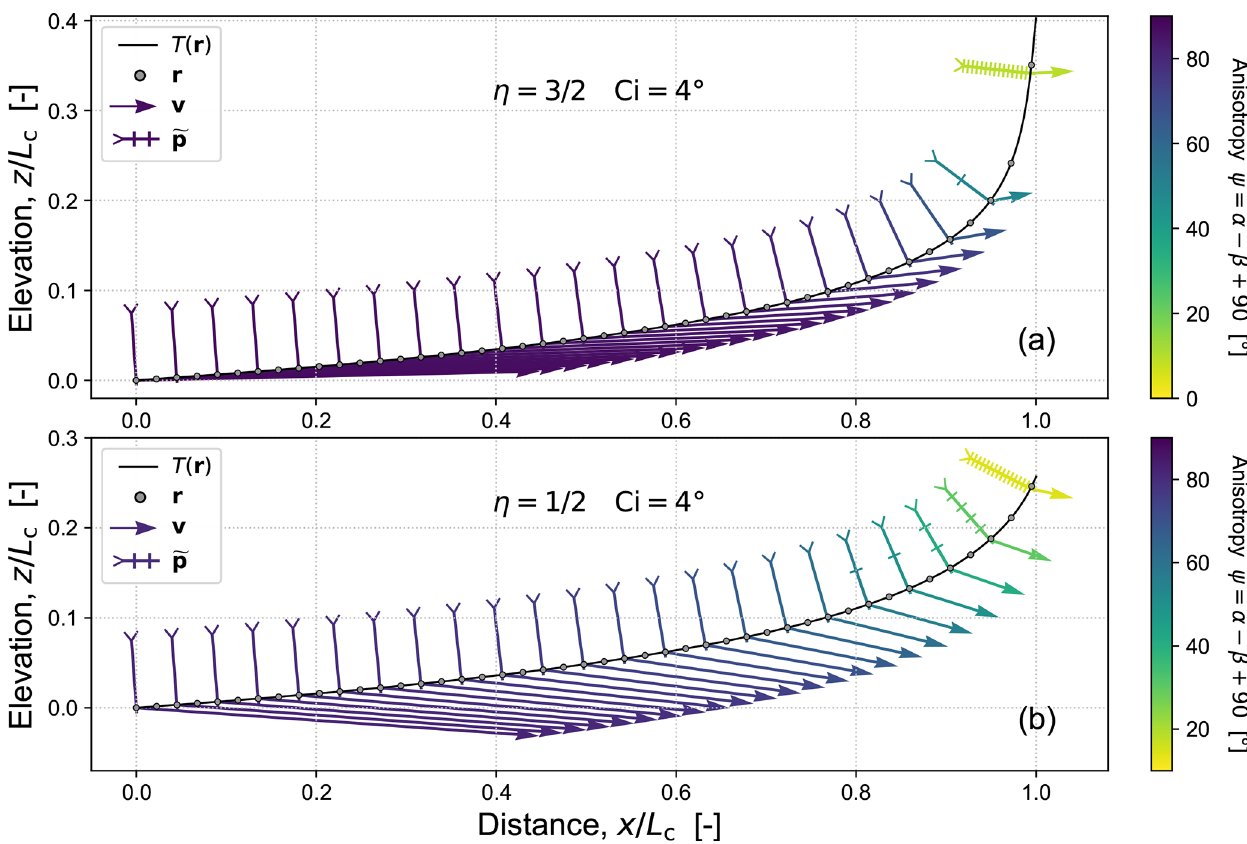
and η = 1 and with µ/η = 1 and Ci = 4 ◦ . Ray 2 2 2